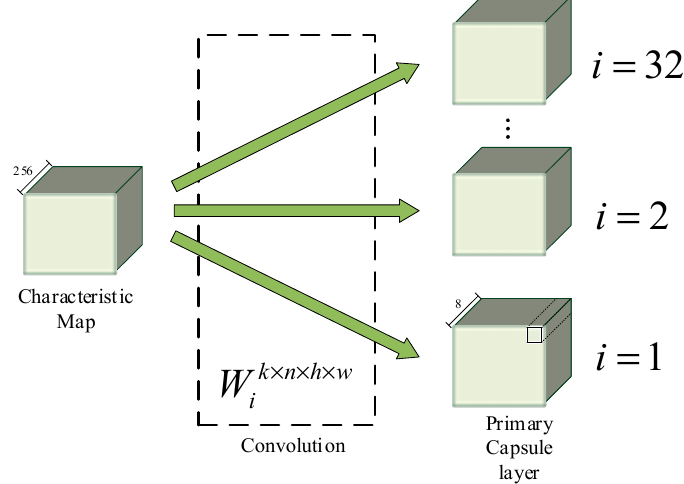
Figure 2. Calculation principle of the capsule layer.